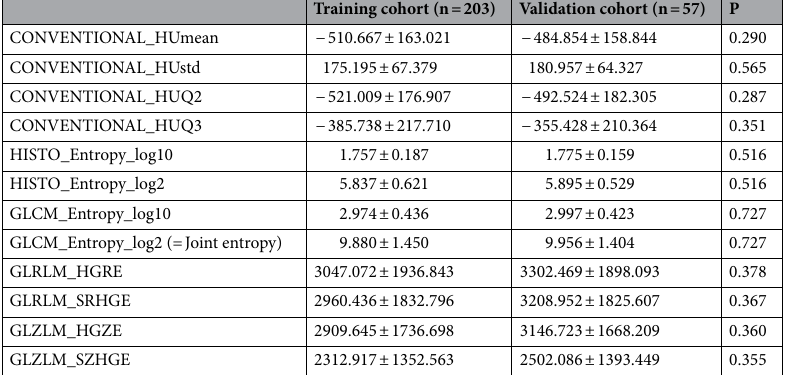
Table 2. Selected radiomic features of the study population with SSNs in the training and validation cohorts. HU hounsfield unit, GLCM gray-level co-occurrence matrix, GLRLM grey-level run length matrix, HGRE high grey-level run emphasis; SRHGE: short-run high grey-level emphasis, GLZLM grey-level zone length matrix, HGZE high grey-level zone emphasis, SZHGE short-zone high grey-level emphasis.